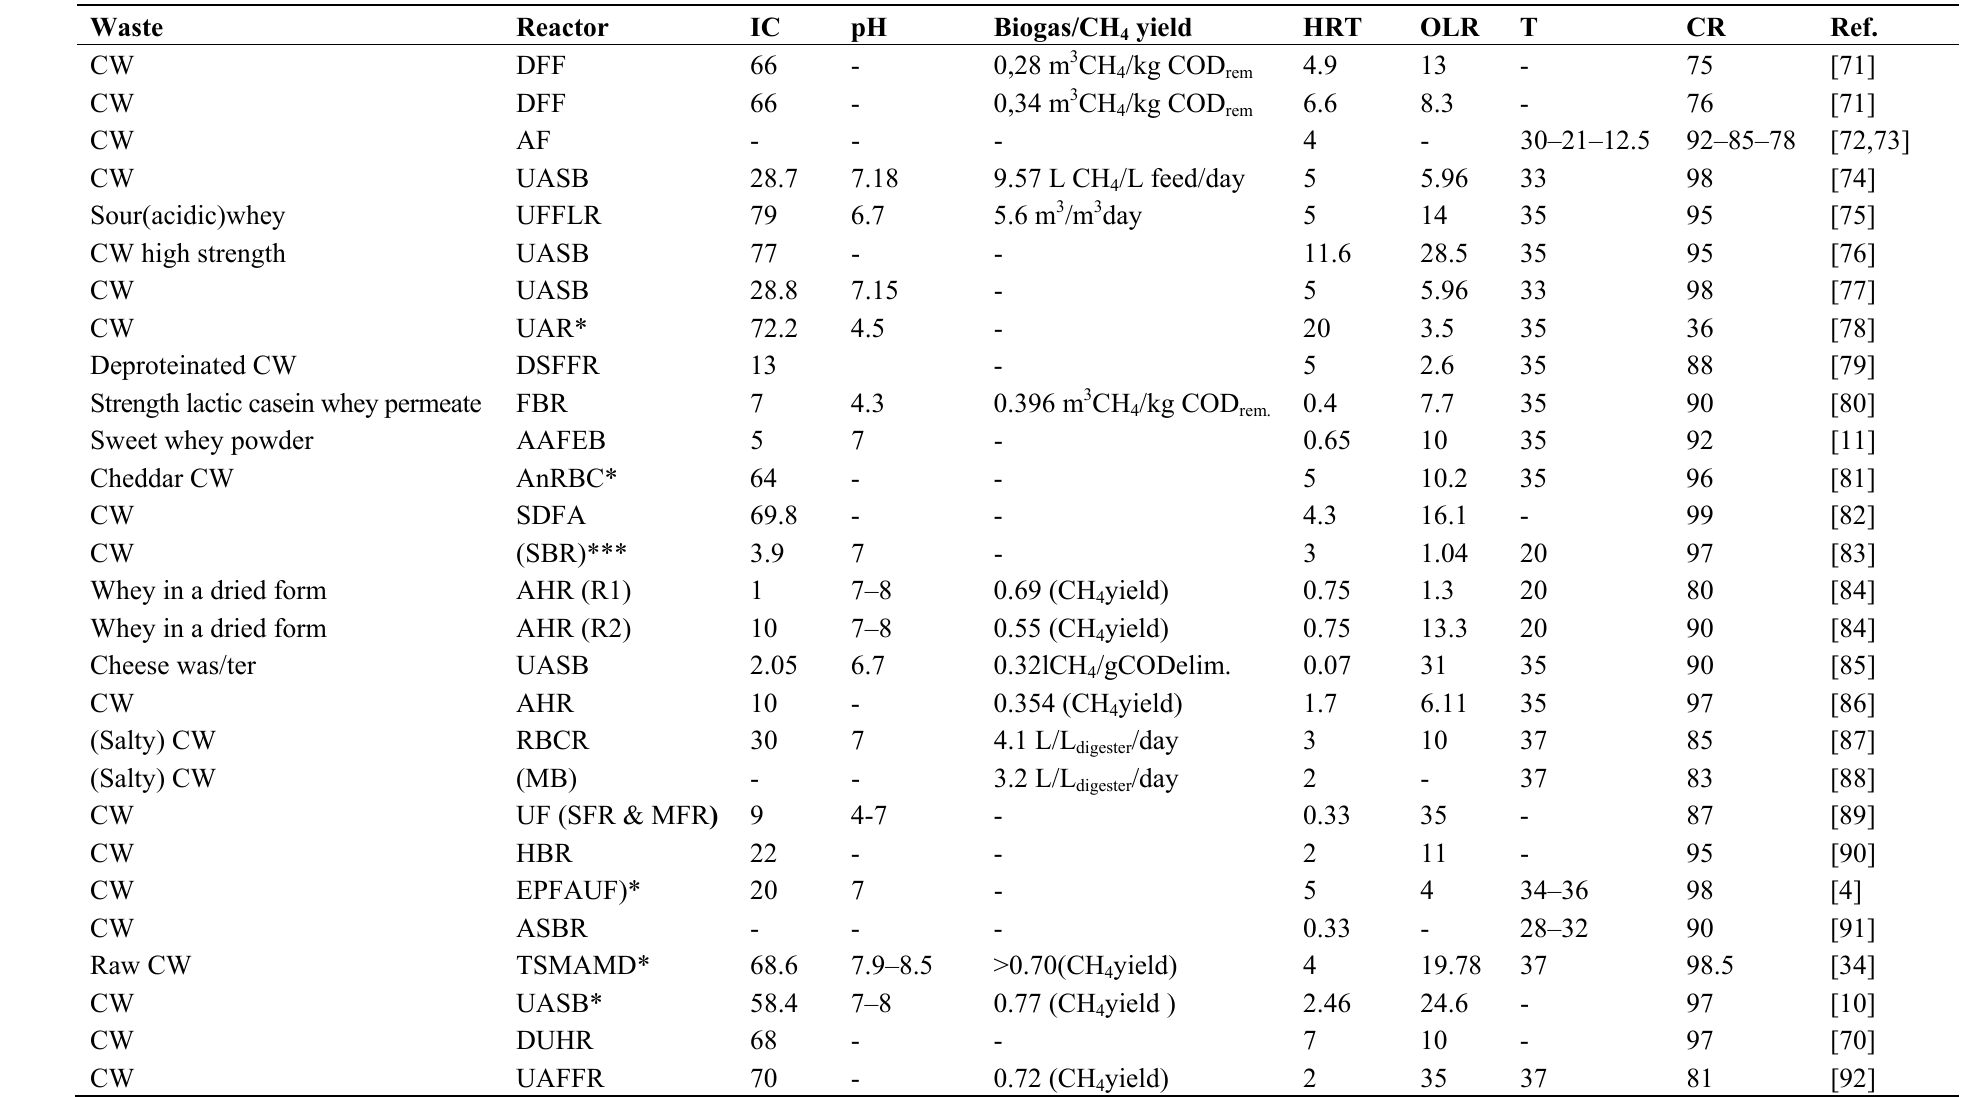
Table 3. Cheese whey treatment